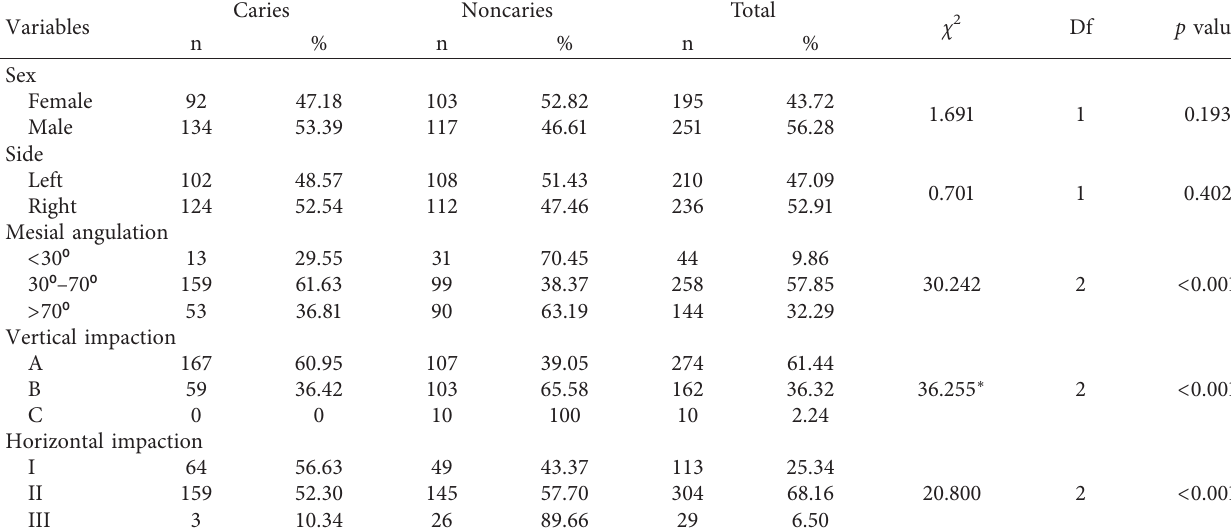
Table 1: Demographic and radiographic characteristics of samples ( N �